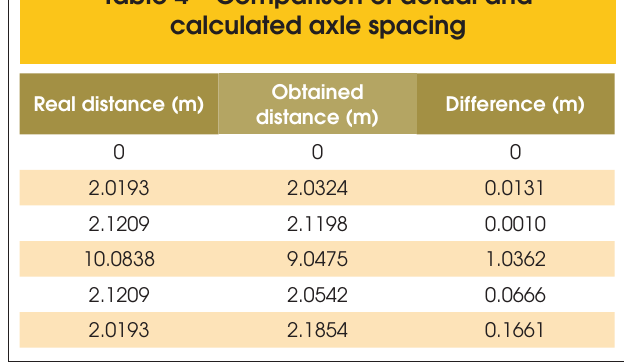
Table 4 – Comparison of actual and calculated axle spacing